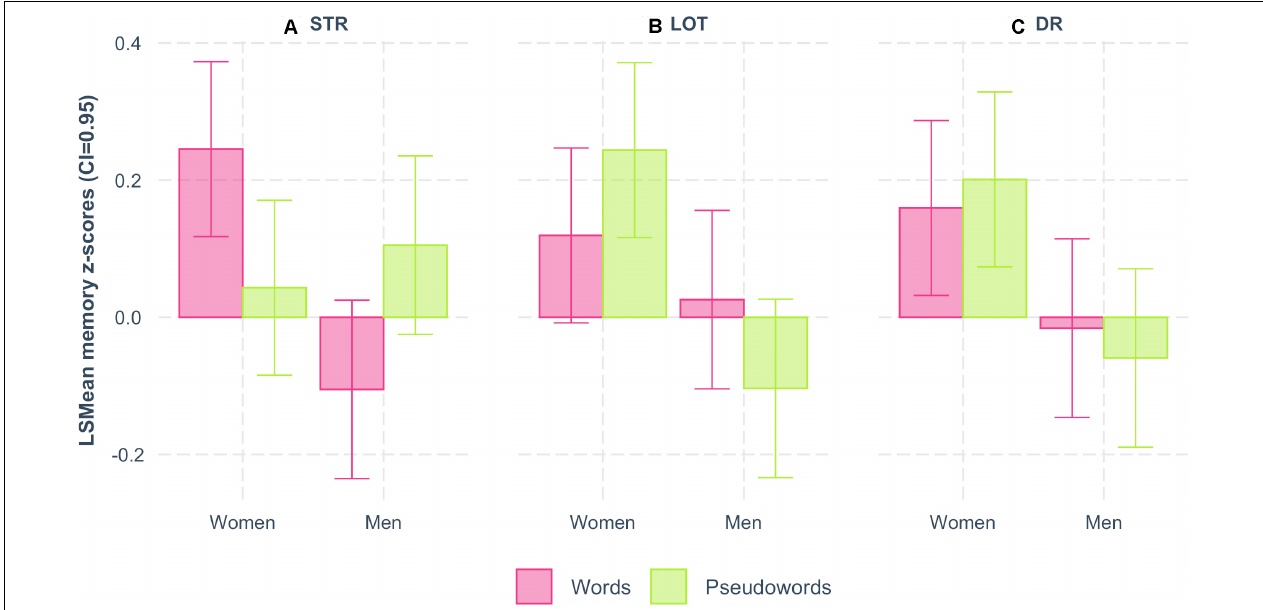
FIGURE 2 | Memory scores as a function of sex. Sex interaction with the type of item (pink: words; green: pseudowords) and memory stages: (A) short-term recall – STR, (B) learning over trials – LOT, and (C) delayed recall – DR. Memory scores (LSmean of z-scores adjusted for age, education, vocabulary scope, rhyming, WMC, and handedness) were significantly higher for words than for pseudowords among women at the STR.